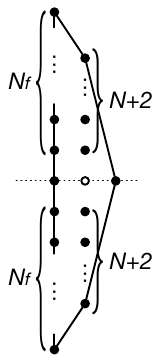
Figure 2 . Dual graph of the 5-brane web diagram with O 5